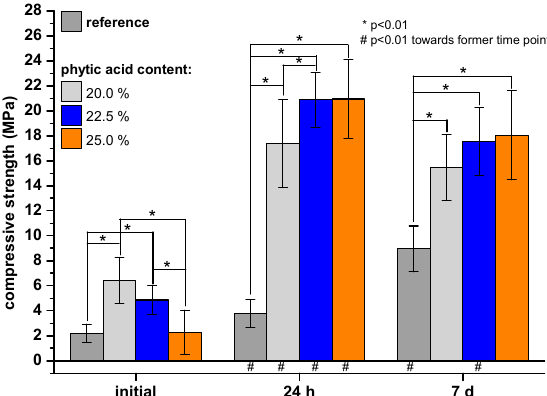
Figure 2. Corresponding XRD patterns initially ( A ) respectively after 7 d ( B ) hardening of the cement prepared at a powder-to-liquid ratio of 2.0 g/mL. Characteristic reflexes are marked with f (farringtonite, PDF-No. 33-0876) respectively n (newberyite, PDF-No. 35-0780) in comparison to JCPDS references. Figure 3 reveals the corresponding adhesive strength of various cement formulations on bovine bone. The blue dotted line marks a strength of 0.2 MPa which was determined 1984 by Weber and Chapman [27] to be a threshold value for bone-bonding agents. Adhesives with a lower strength would not be feasible during surgery [27]. Initially, all samples showed an appropriate adhesiveness on bone between 0.75 ± 0.20 (reference) to 1.22 ± 0.41 MPa (25.0%). Samples with the lowest phytic acid content represented an exception, as their adhesiveness laid underneath the as-mentioned threshold value. After ageing, only the composition with a 25.0% phytic acid amount had an appropriate adhesiveness of 0.81 ± 0.12 MPa still after 7 d. With this composition, it was possible to fix a manually broken porcine cadaver mandible such that after 10 min the bonding slit withstood the weight of the heavier part as demonstrated in Figure 3B.